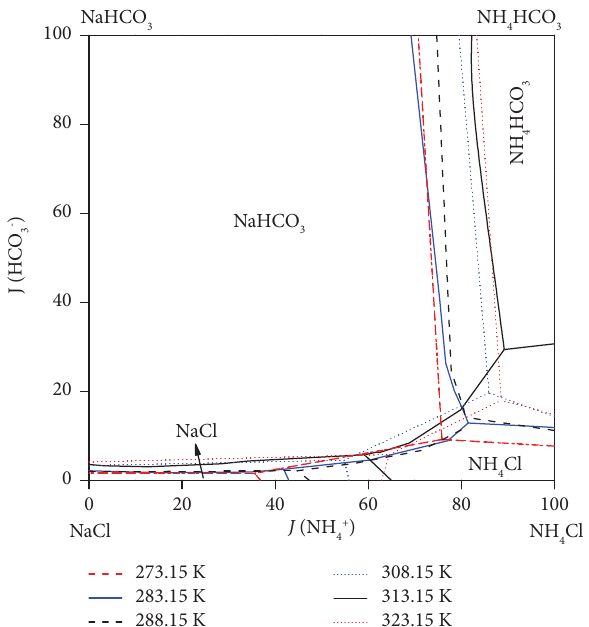
4 Cl+NaHCO 3 +NH 4 HCO 3 +H 2 O) at 273.15, 283.15, 308.15, 313.15, and